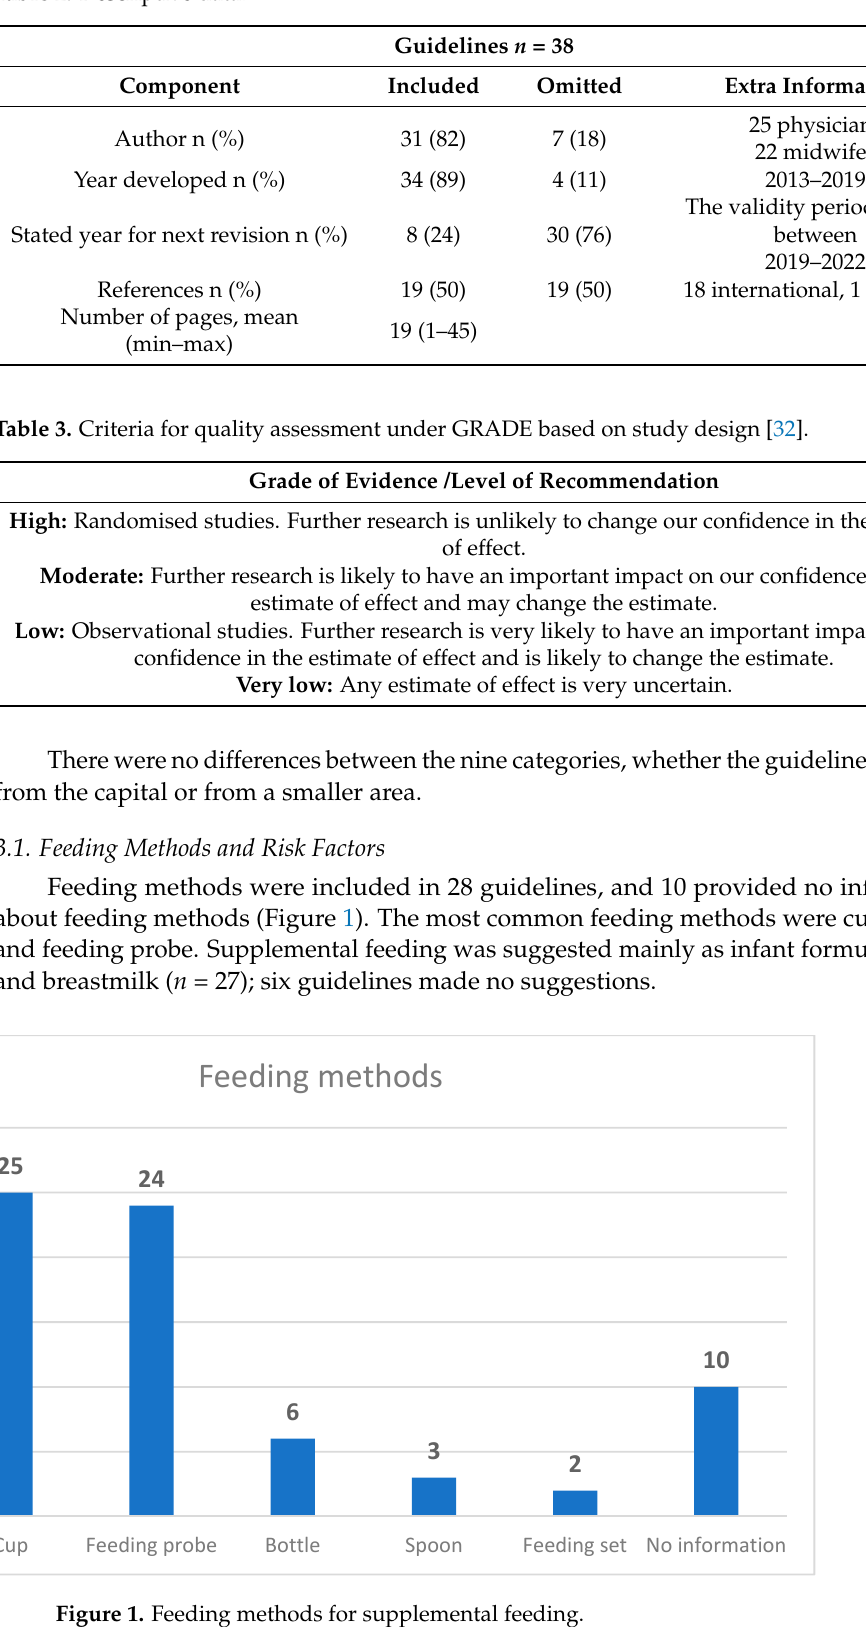
Table 2. Descriptive data.